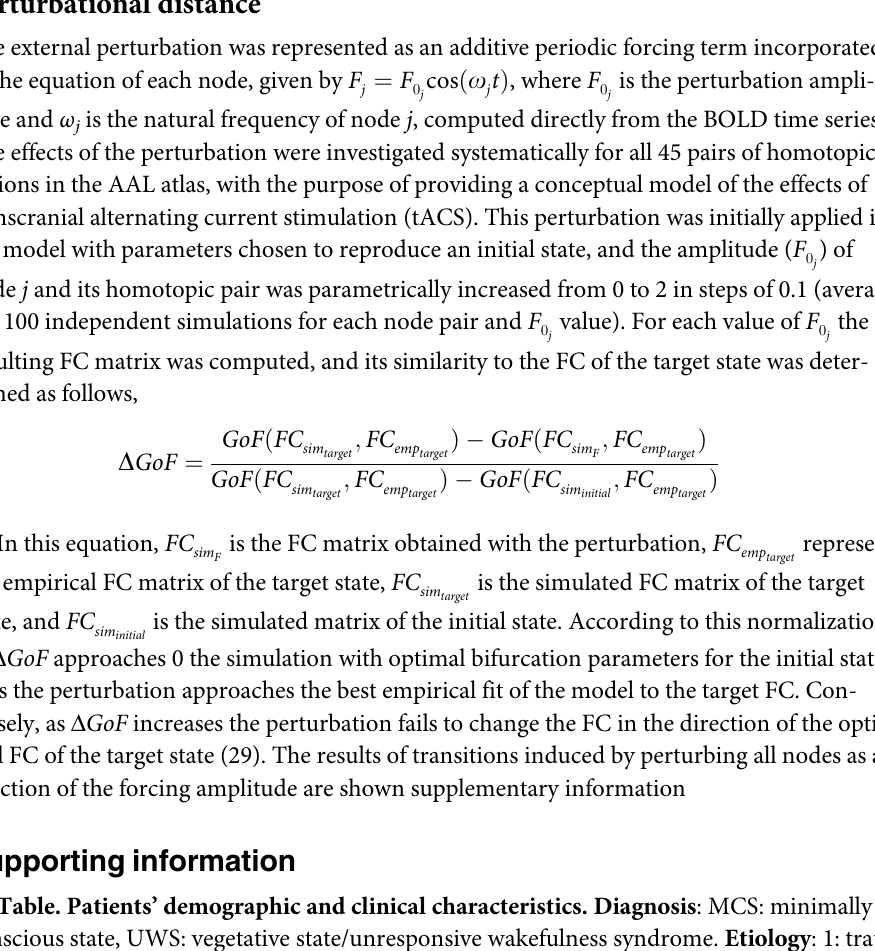
S1 Table. Patients’ demographic and clinical characteristics. Diagnosis : MCS: minimally conscious state, UWS: vegetative state/unresponsive wakefulness syndrome. Etiology : 1: